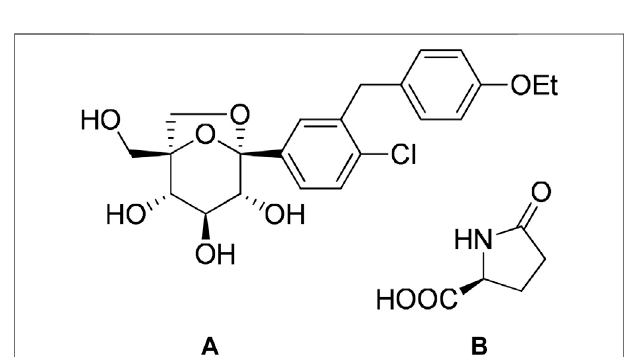
FIGURE 6 | Chemical structures of A. Ertugli fl ozin and B. L -pyroglutamic acid.